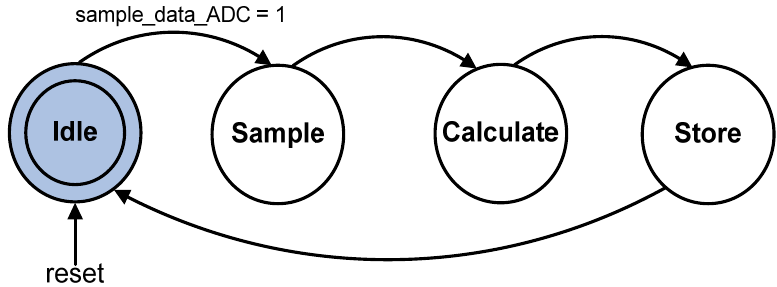
Figure 10. Fuzzy Error Conversion state diagram.